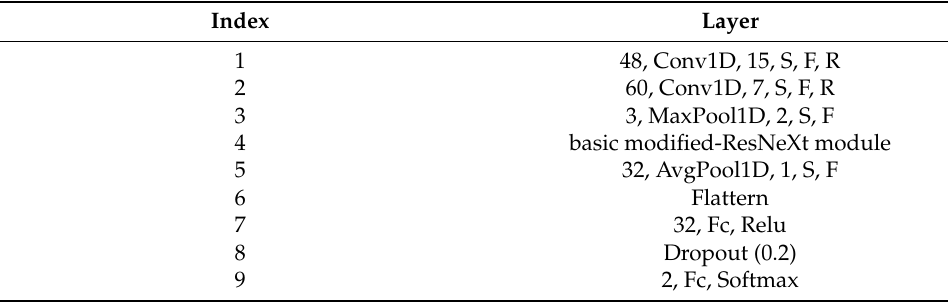
Figure 1. Basic modified-ResNeXt module, where the first parameter denotes the number of convolutional kernels, the second parameter ‘Conv1D’ denotes the one-dimensional convolutional layer, the third parameter denotes the size of convolutional kernels, the fourth parameter ‘S’ denotes padding to the same size, the fifth parameter ‘F’ denotes channel order of the input data immediately follows the batch, the last parameter ‘R’ denotes Relu activation function. Table 1. Structure of proposed modified-ResNeXt